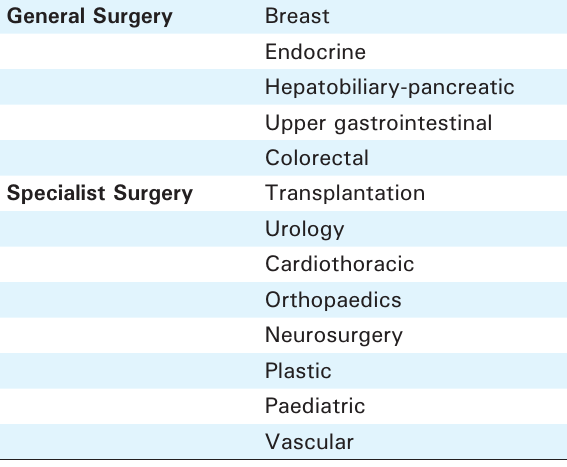
Table 1. Surgical